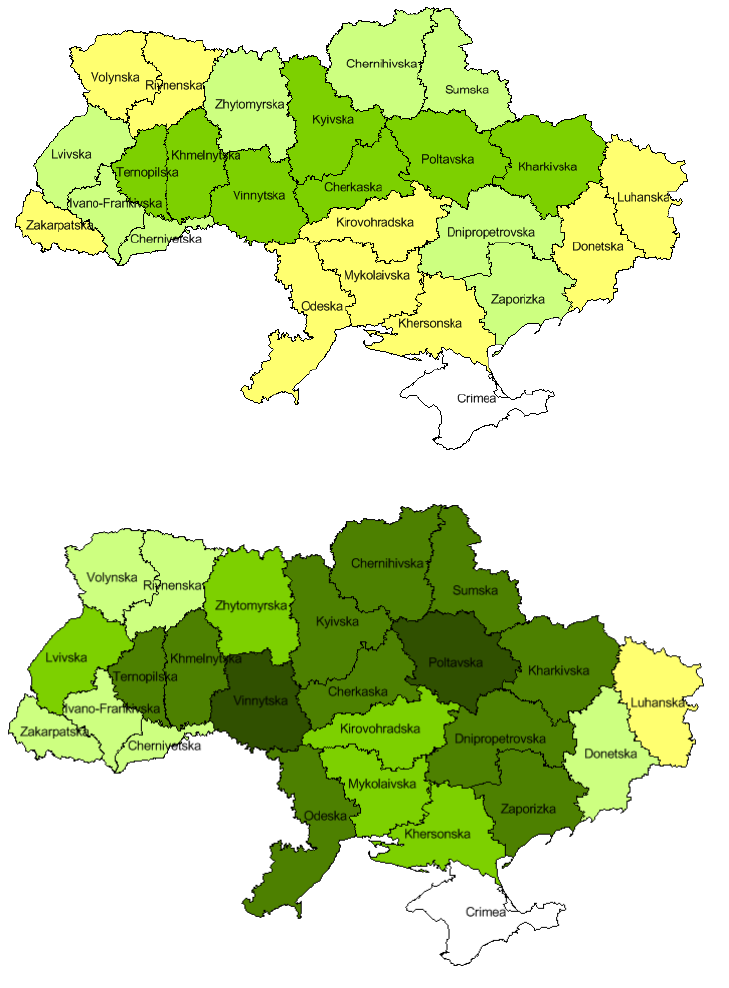
Figure 7. Assessment of economic potential for bioenergy generation purposes from the main crop residues within the BAU (upper map) and INNO (bottom map) scenarios. Note: no data available for the Autonomous Republic of Crimea. Source: own calculations.